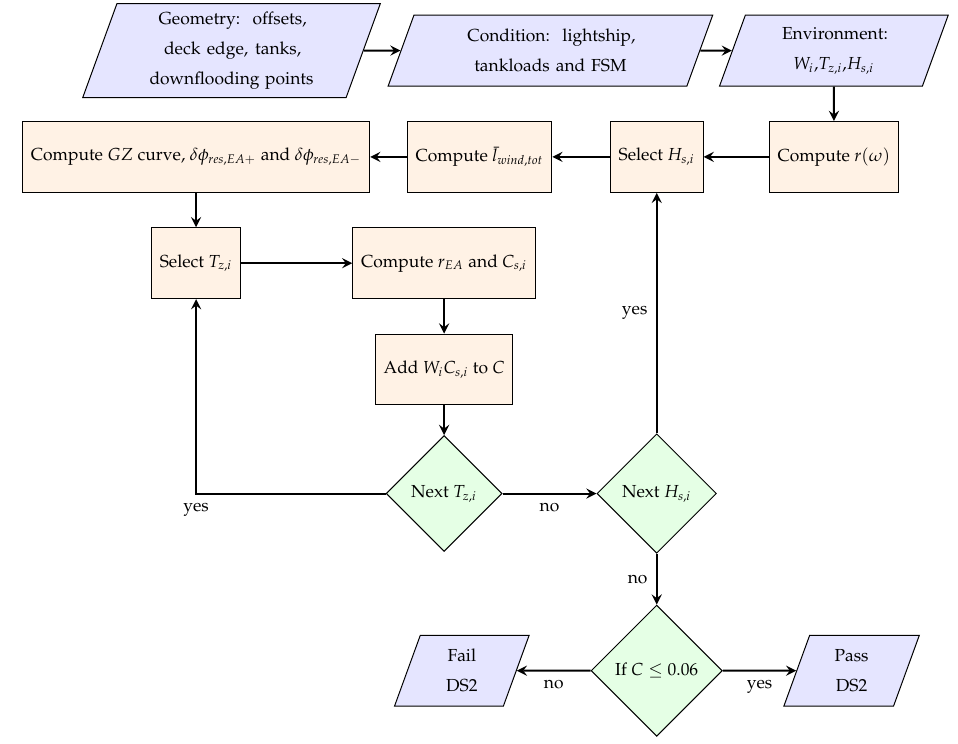
Figure 5. Dead Ship Level 2 algorithm process diagram.